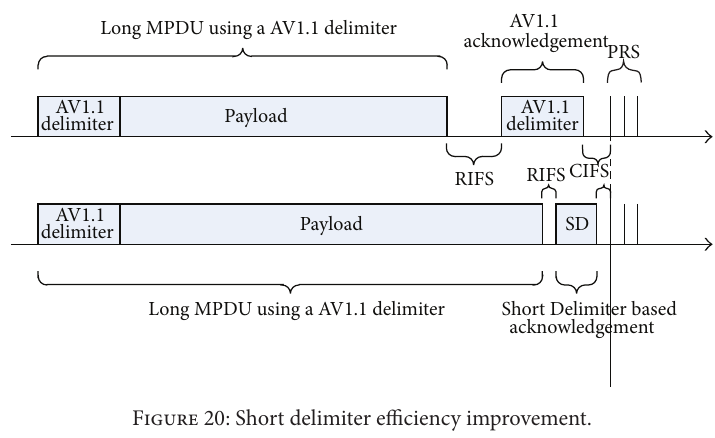
Figure 20: Short delimiter efficiency improvement.